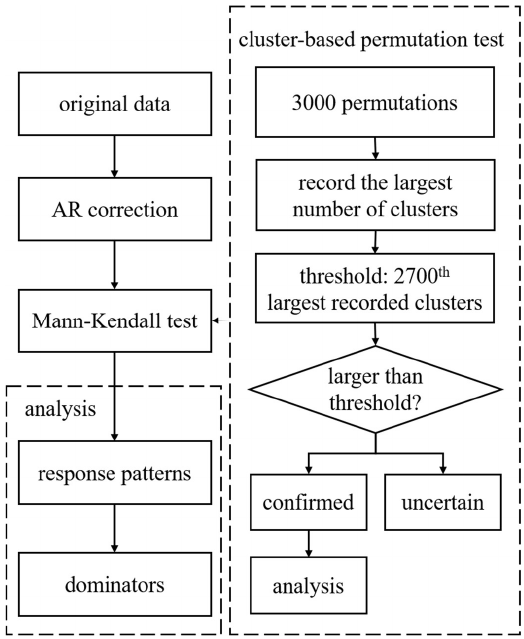
Figure 1. The framework of the whole methodology.